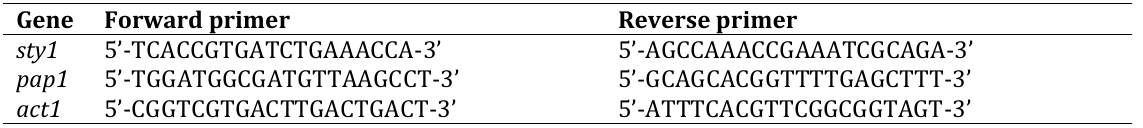
Table I. Primer pairs for Real-Time PCR used in this study Gene Forward